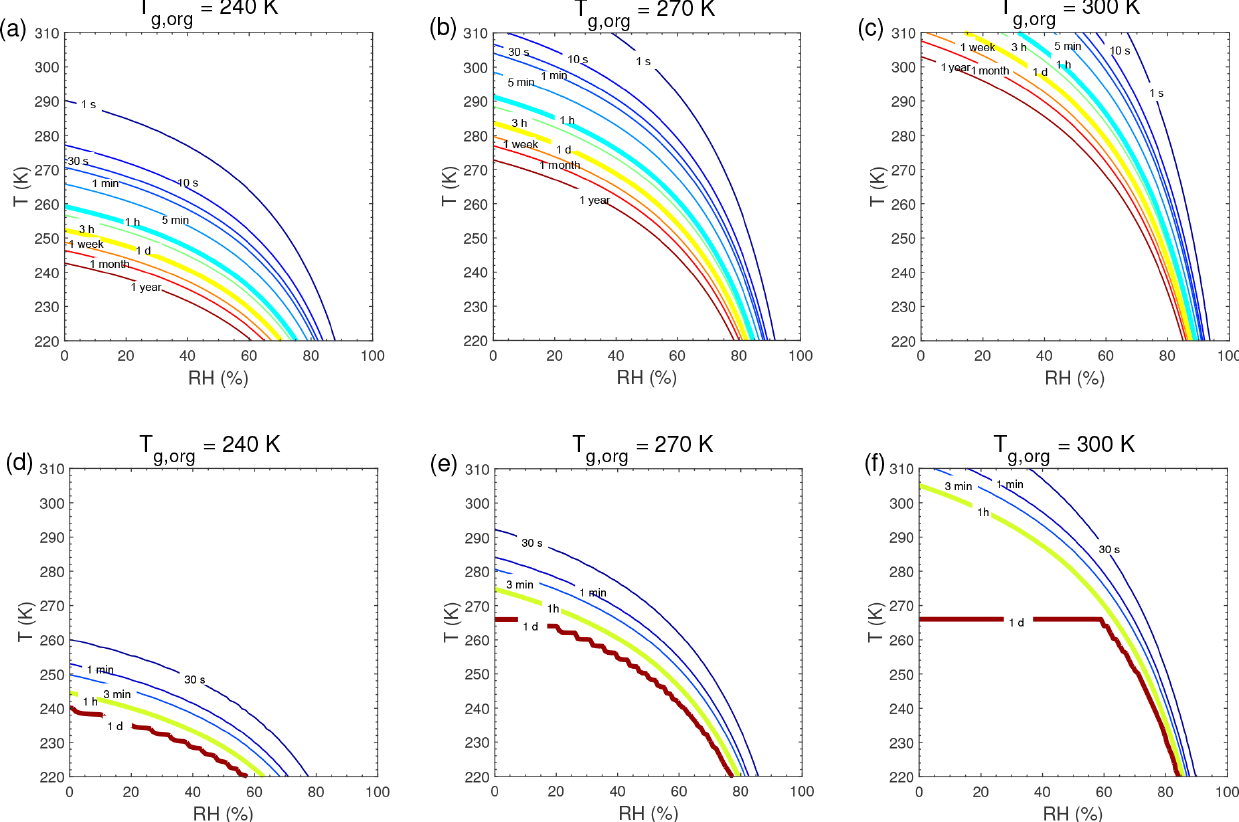
Figure A1. Equilibration timescale ( τ eq ) as a function of temperature and relative humidity in the closed system. The glass transition temperatures of preexisting particles at dry conditions ( T g , org ) are set to (a, d) 240K, (b, e) 270K, and (c, f) 300K. The mass concentration of preexisting particles is 20µgm − 3 . The saturation mass concentration ( C 0 ) of the condensing compound is (a–c) 10 3 µgm − 3 and (d– f) 0.1µgm − 3 .